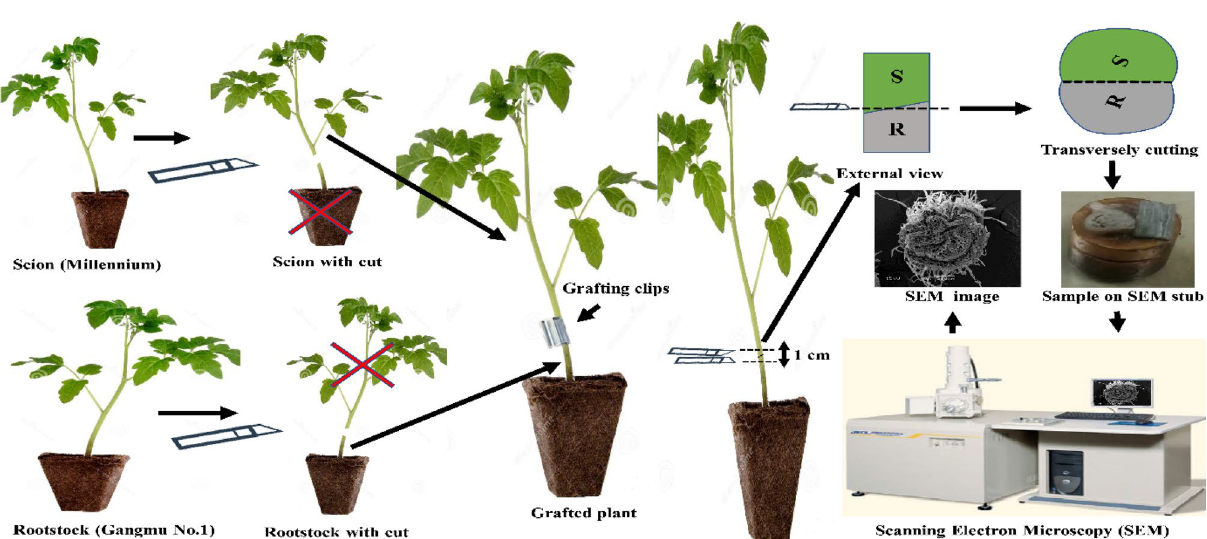
Figure 9. Illustration of the grafting procedure and preparing samples for examination with scanning electron microscopy